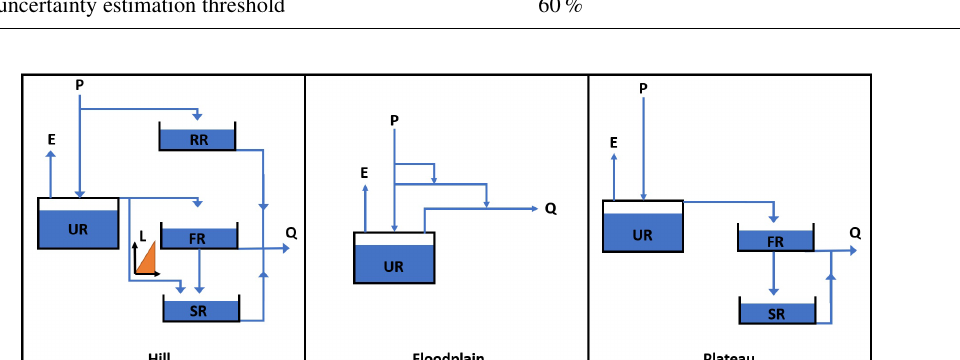
Figure 5. MIKA-SHA_SUPERFLEX model configuration ( P – precipitation; E – evaporation; Q – total discharge; RR – riparian